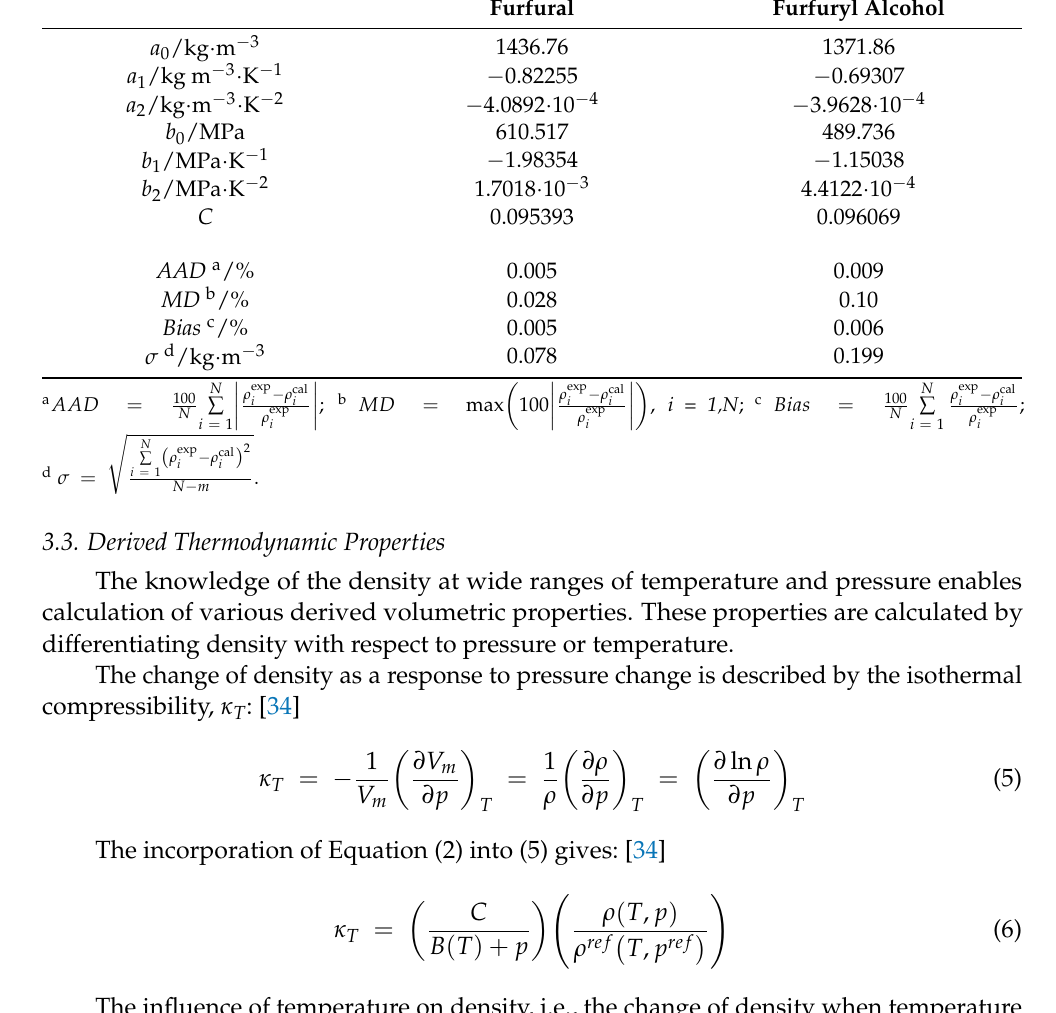
Table 5. Parameters of the modified Tammann–Tait equation and comparison criteria for furfural and furfuryl alcohol at temperatures (293.15–413.15) K and at pressures up to 60 MPa. Furfural Furfuryl Alcohol a 0 /kg · m − 3 1436.76